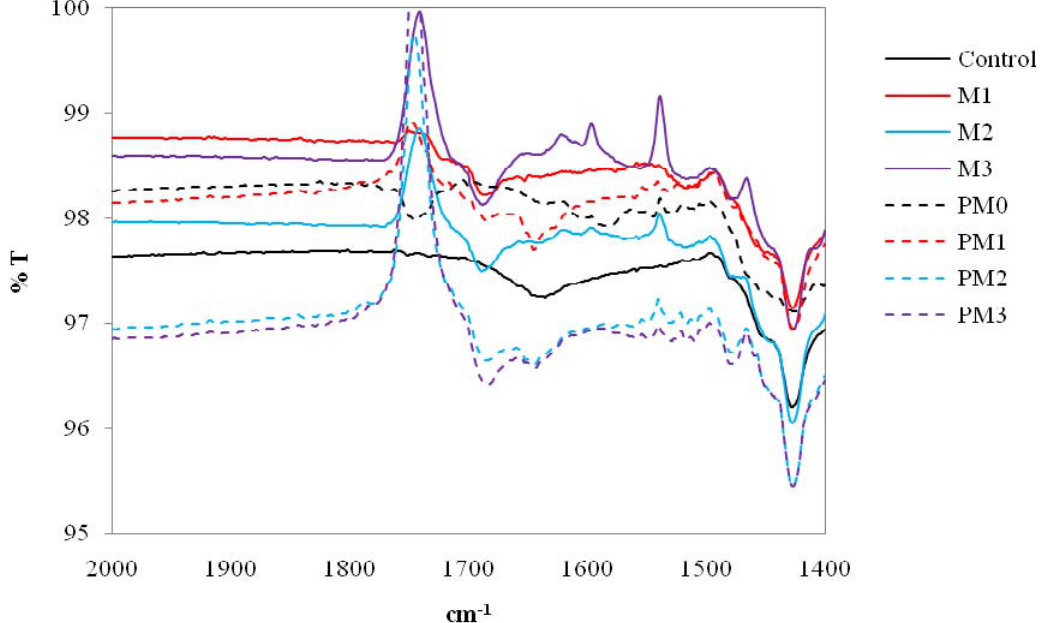
Figure 5. FTIR spectra of anti-microbial treated cotton specimen at 2000 to 1400 cm − 1 .